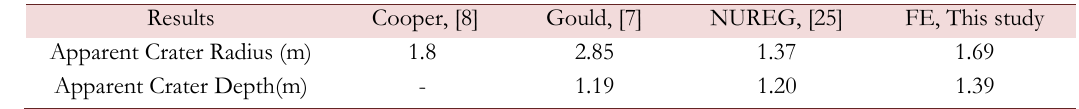
Table 5 : Crater depth and width from numerical analysis and empirical